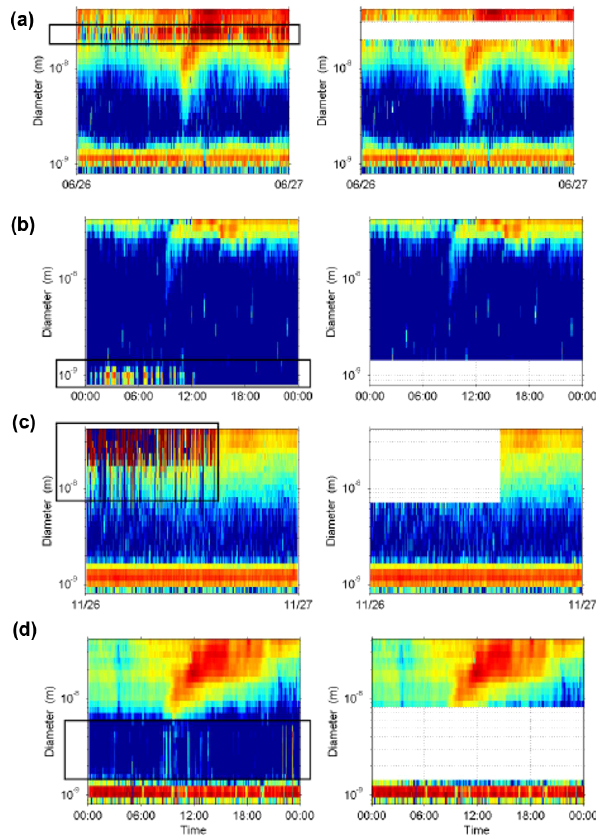
Figure 16. Typical faulty ion number size distributions before (left column, problematic area boxed) and after (right column) cleaning and quality checks. The bad or missing data was selected and re- placed with − 999 . 99 using a MATLAB script. The faulty data was caused by (a) continuously noisy electrometer, (b) bad grounding at the top of the DMA (partly missing cluster ions), (c) dirt in the bottom of the DMA (high noise), and (d) classifying electric field inside the DMA as not correct due to a bad BNC (Bayonet–Neill– Concelman) cable connection (intermediate ions